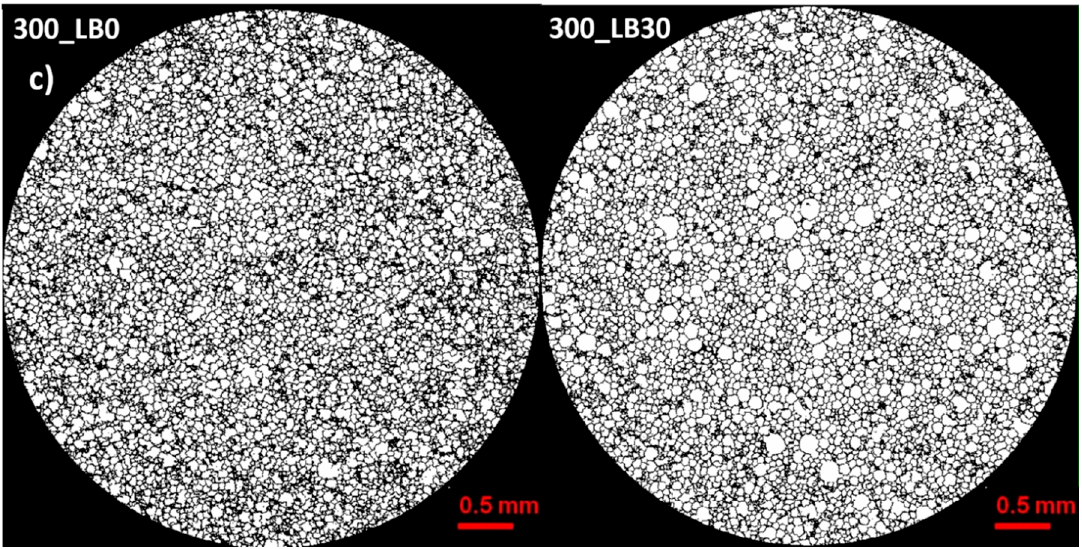
Figure 2. 2D images of PUR-PIR foams: ( a ) I ISO = 200, ( b ) I ISO = 250, ( c ) I ISO = 300.